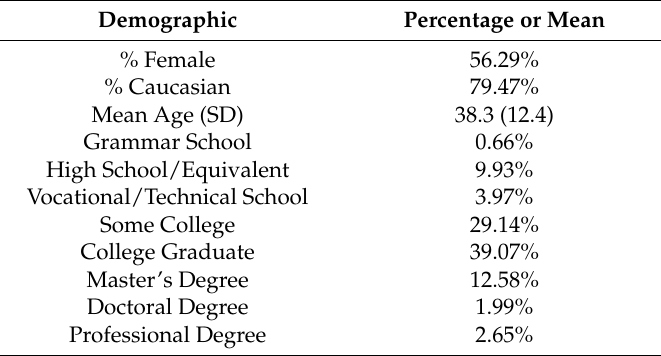
Table 1. Summary of Demographic Characteristics ( n =